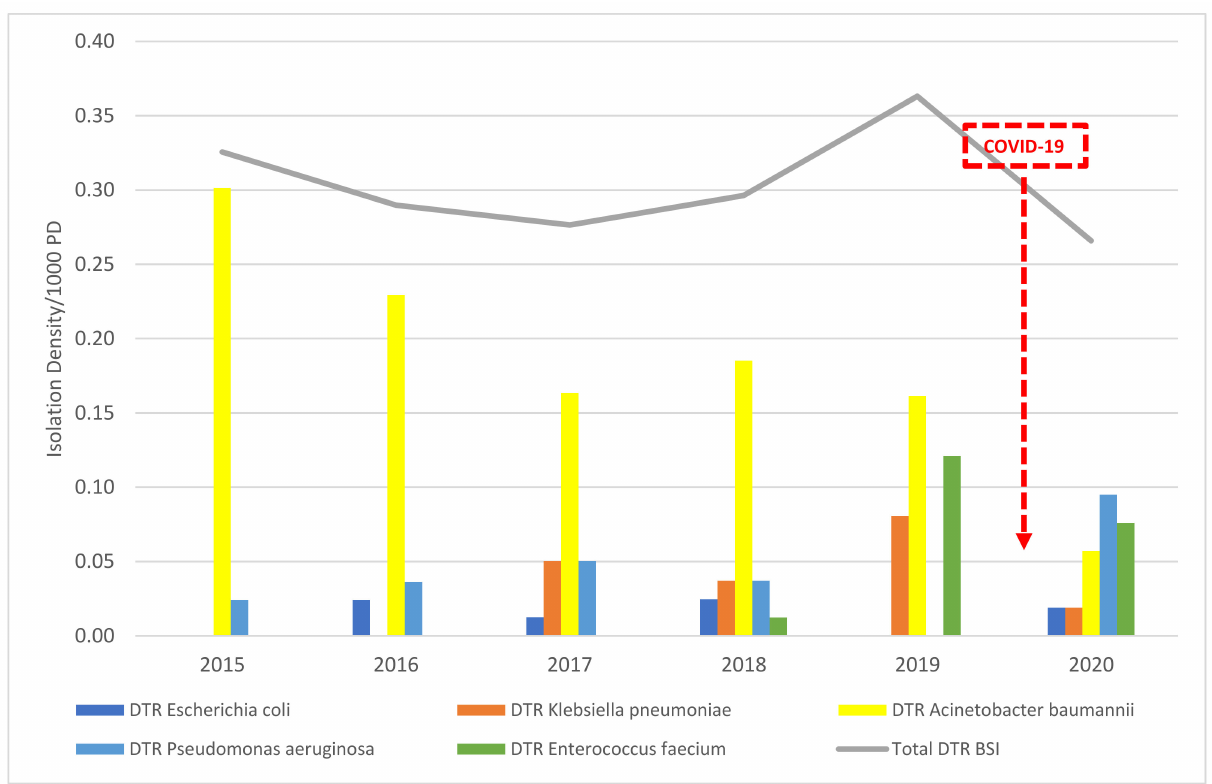
Figure 2. The isolation density per 1000 PD of difficult-to-treat (DTR) bloodstream isolates from 2015–2020 at